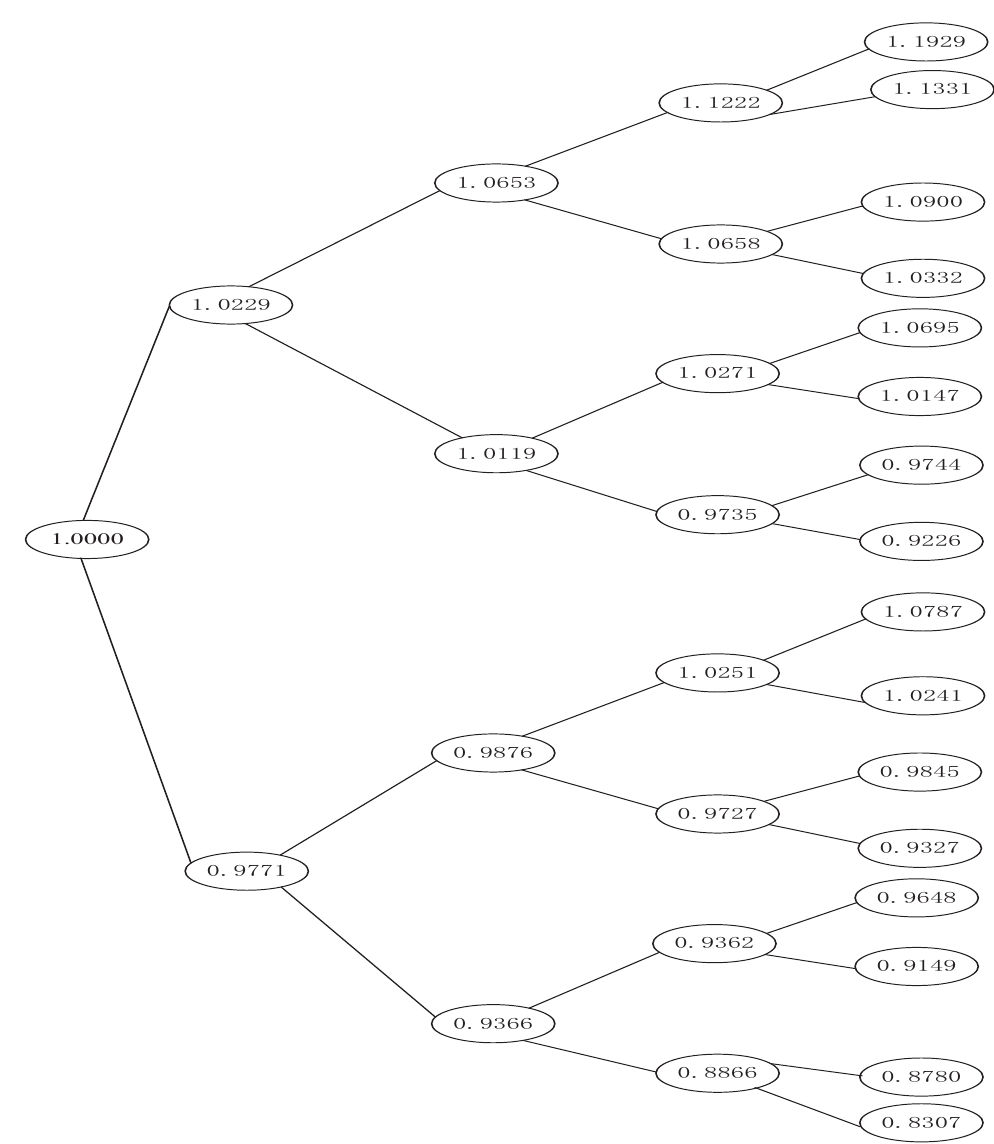
Figure 4. A four-step Hermite binomial tree with arbitrage, H = 0.85 and k =